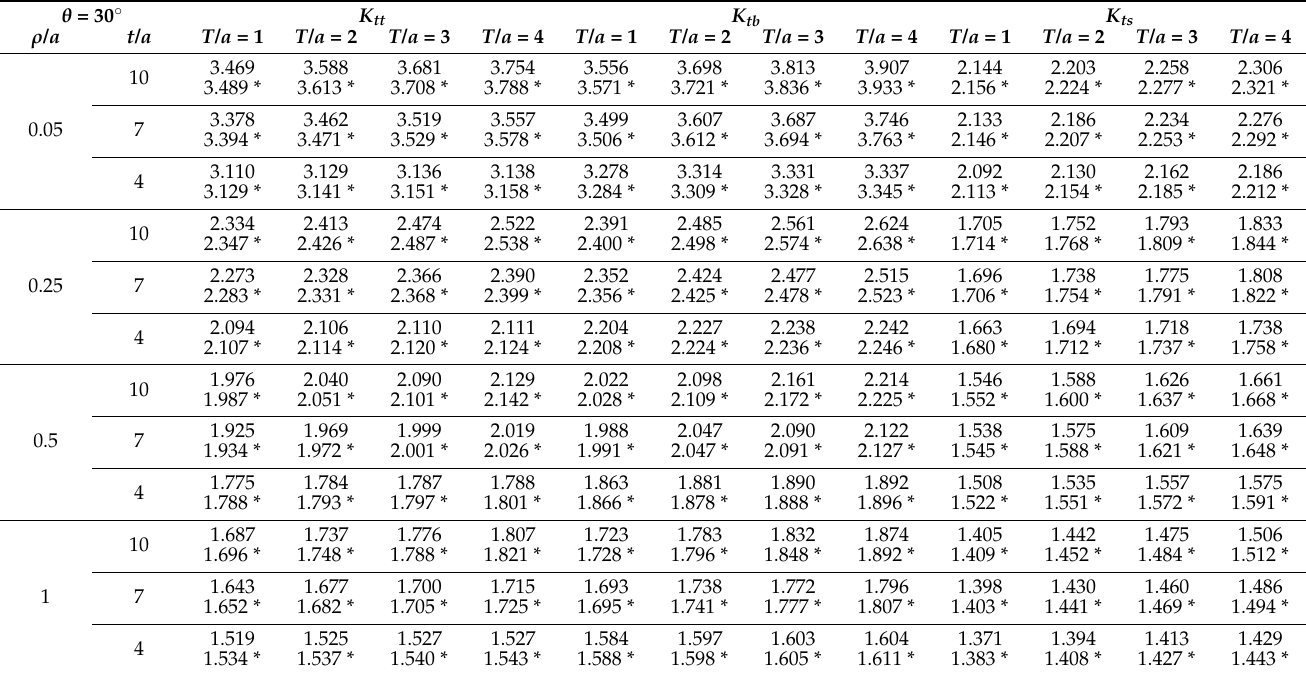
Table 5. Comparison of SCF’s values calculated using Equations (A1)–(A3) (*) to the corresponding FEM results for various T / a ratios, while θ = 30 ◦